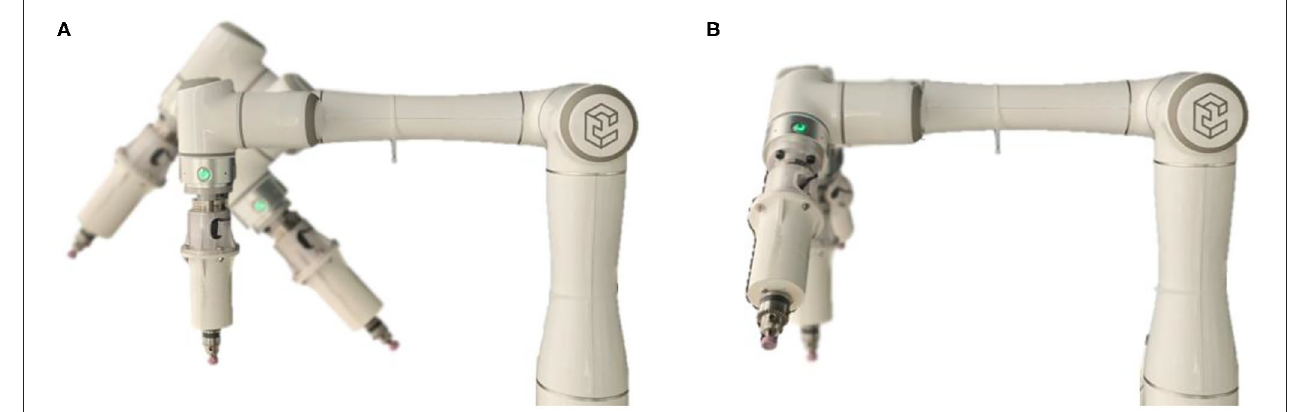
FIGURE 3 | Force compensation test with different end positions and angles. (A) Posture transformation in the Y-O-Z plane. (B) Posture transformation in the Z-O-X plane.